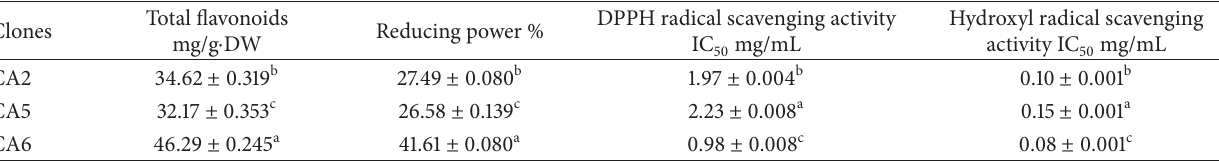
Table 2: The total flavonoid contents and antioxidant activity of crude extract from leaves of clones of C. bungei C. A. Mey.